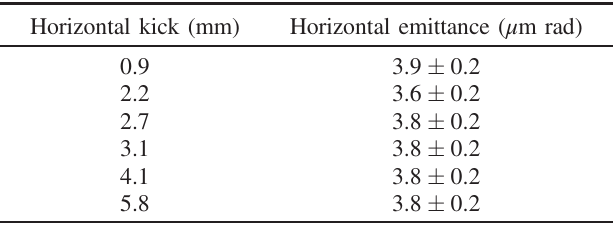
TABLE III. Horizontal emittance measurements performed with the LHC wire scanner in the 2017 MD1.